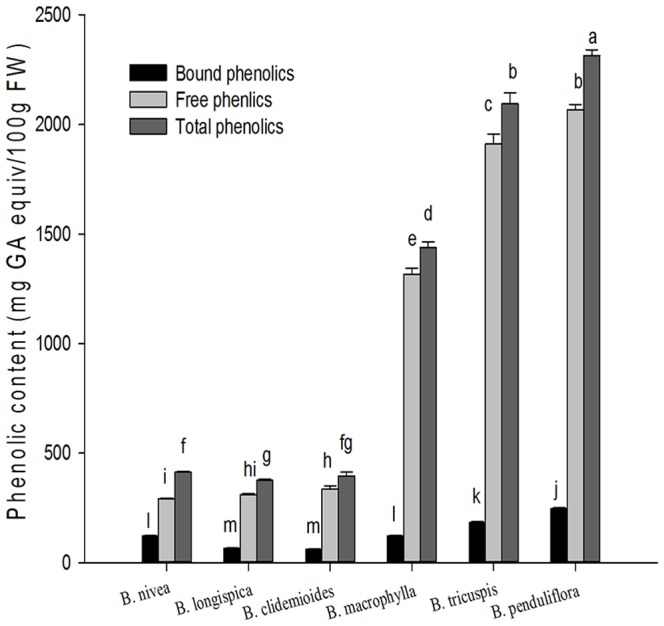
Phenolic contents in six species of ramie leaves (mean ± SD, n = 3).Bars with no letters in common are significantly different (p<0.05).